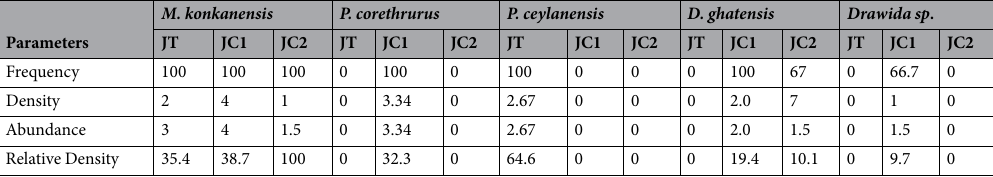
Table 1. Earthworm population in the study area (After the 12 months of